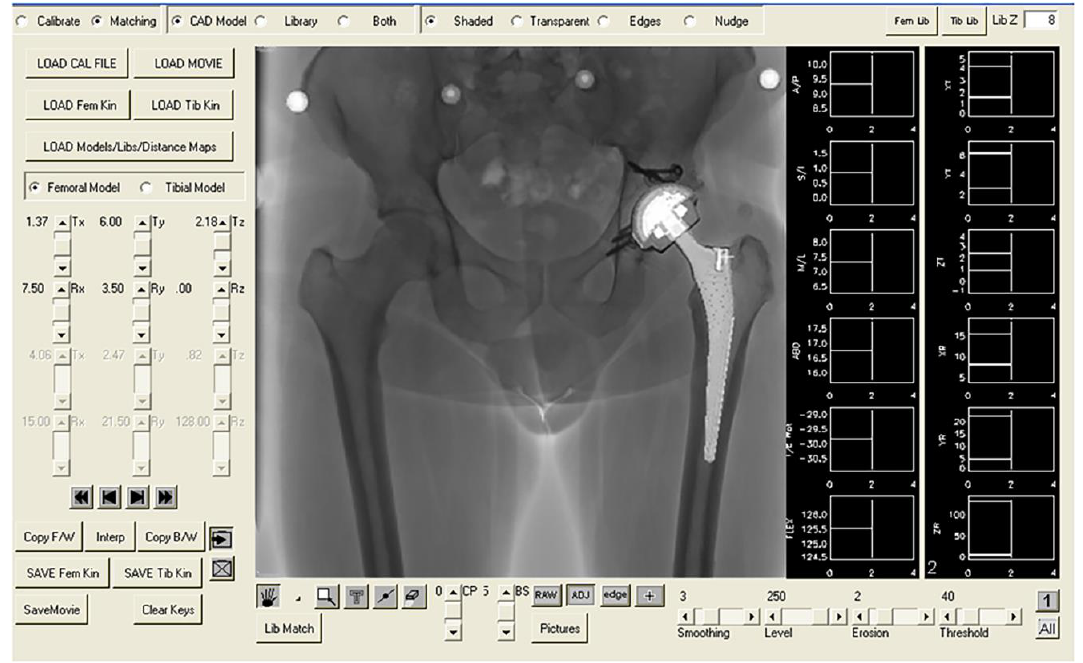
Figure 2. Screenshot of the tools for the 2D-to-3D registration for 3D videofluoroscopy analysis (VA).